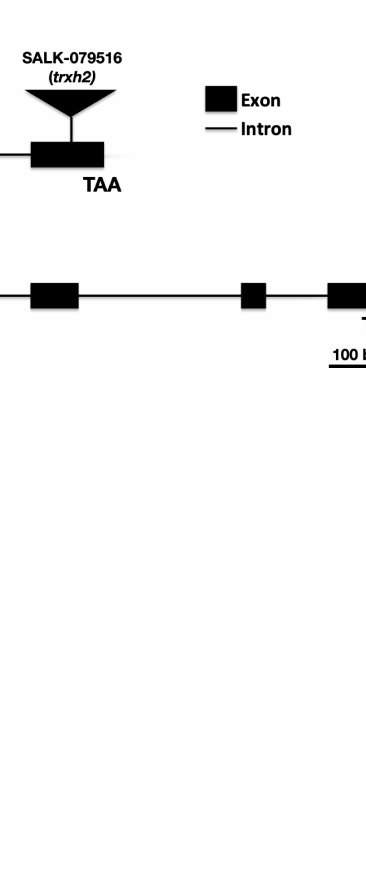
Figure 2. Molecular characterization of trxh2 , trxo1 and trxo1h2 . ( A ) The scheme of T-DNA insertion sites in trxh2 and trxo1 mutants. ( B ) The transcript levels of Trx h 2 and Trx o 1 in mutant lines compared to the wild type (Col-0). Mean values and standard errors derived from 6 biological replicates. The statistical analyses were performed using ANOVA and the Dunnett’s test (* p < 0.05, in comparison to the wild type).